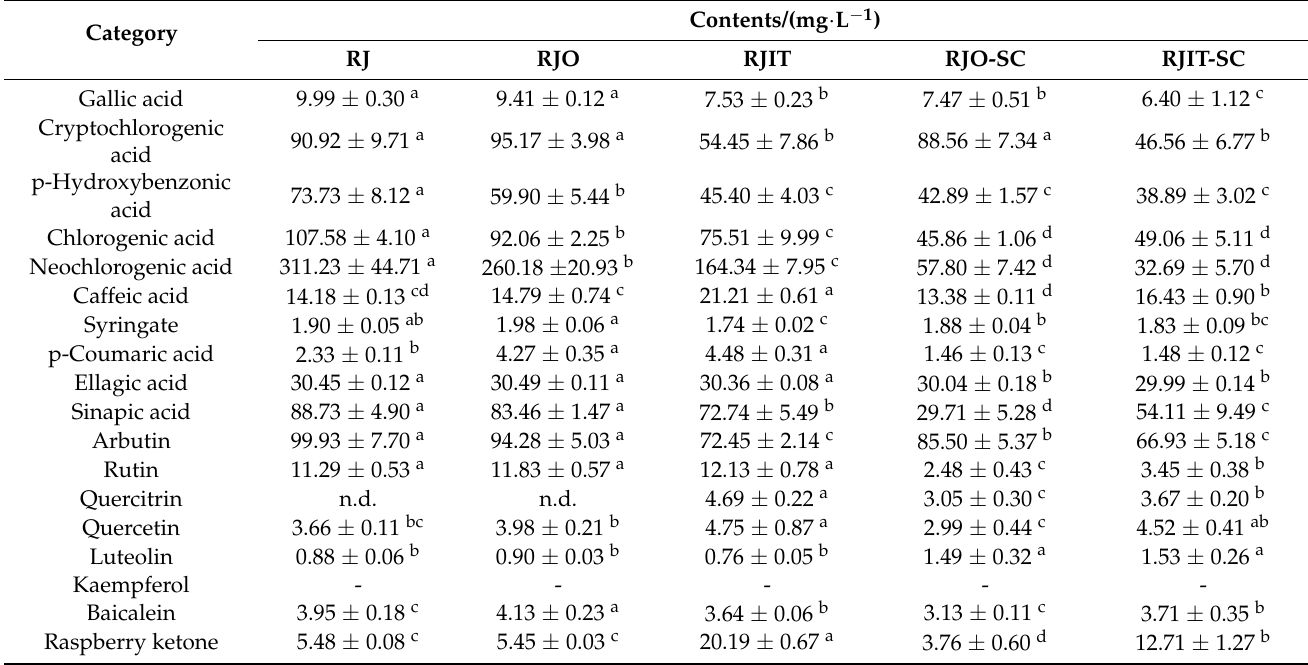
Table 3. Effect of I . terricola WJL-G4 on phenolic compounds of red raspberry